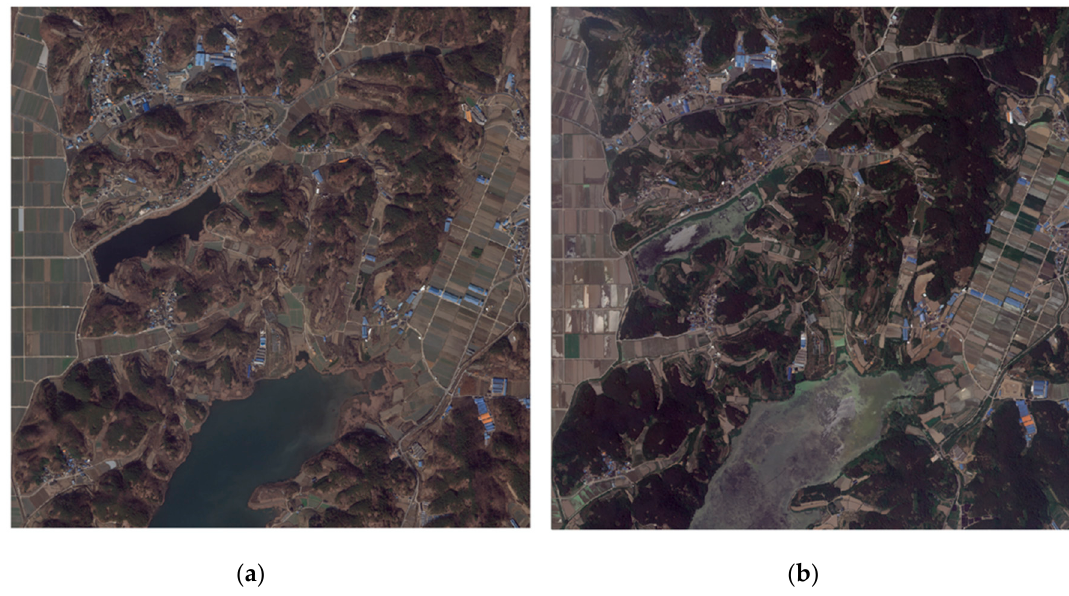
Figure 3. The experimental images from site 3: ( a ) subject image acquired on 30 October 2015, ( b ) reference image acquired on 18 June 2016.